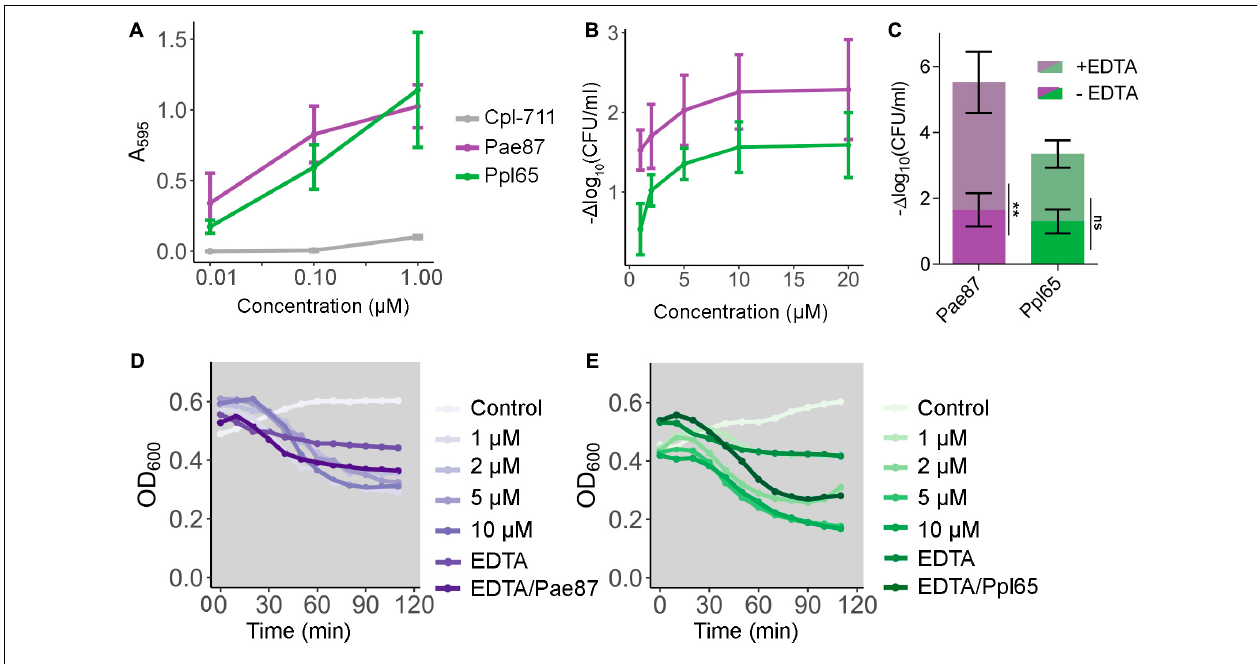
FIGURE 5 | Pae87 and Ppl65 activity assays. (A) Muralytic activity against Remazol Brilliant Blue (RBB)-labeled purified P. aeruginosa PAO1 sacculi. (B) Viability cell count decrease of P. aeruginosa PAO1 cell suspensions treated with different concentrations of Pae87 or Ppl65 for 2 h at 37 ◦ C with respect to an untreated control. (C) Bactericidal activity of 10 µ M of Pae87 or Ppl65 against PAO1 cell suspensions in the presence or absence of 0.5 mM EDTA. Differences in the viable counts with respect to the corresponding control (containing or not 0.5 mM EDTA) are presented. A two-way ANOVA was applied followed by Bonferroni post-test to determine significant differences between adding or not adding EDTA (** p ≤ 0.01; ns, non-significant). (D,E) Turbidity decrease of P. aeruginosa PAO1 cell suspensions treated with different concentrations of Pae87 or Ppl65, with 0.5 mM EDTA or with 10 µ M of protein plus 0.5 mM EDTA. Representative results are shown.